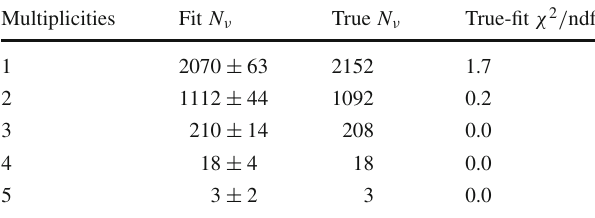
Table 5 Fitted and true number of neutrino events for the MC default sample for different multiplicity bins. The last column shows good agreement between the fit results and true content for different